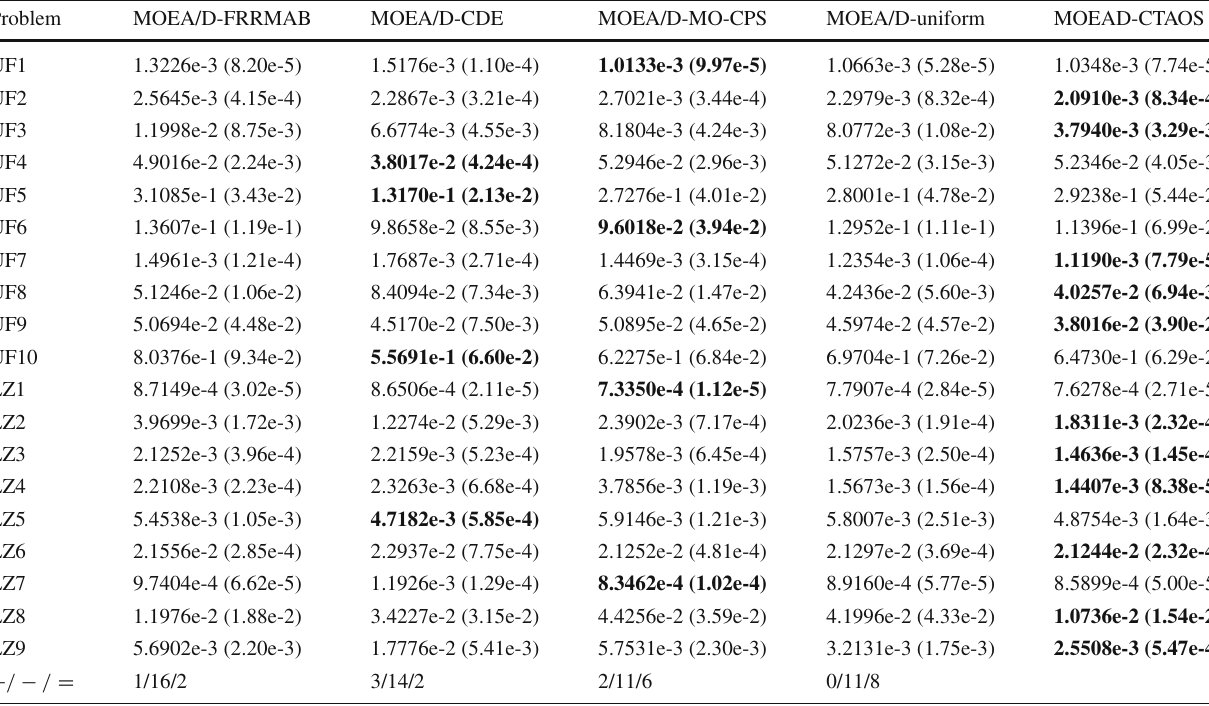
Table 3 Average and standard deviation IGD values obtained by MOEA/D variants with different AOS methods on each benchmark (30 runs) Problem